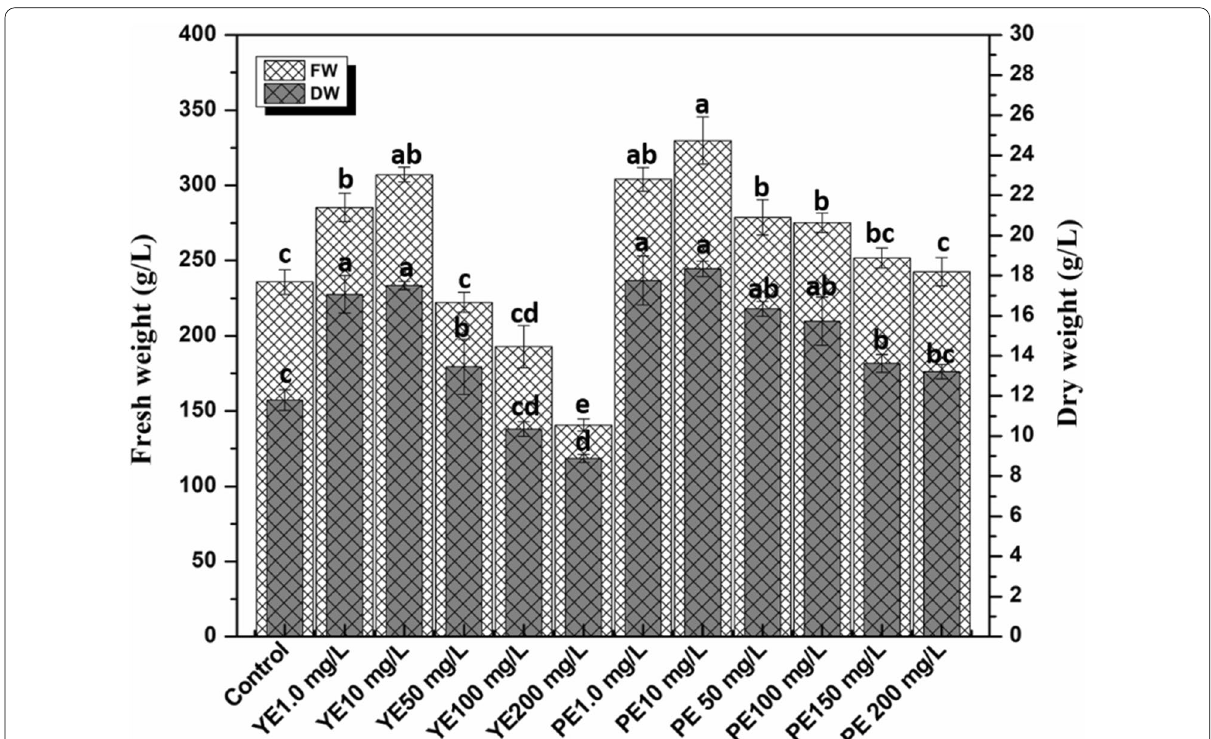
Fig. 3 Biomass accumulation in Ajuga integrifolia agitated micro‑shoot cultures in response to yeast extract (YE) and pectin (PE). Values represent means standard errors from triplicates; different letters indicate significant differences at p < ±